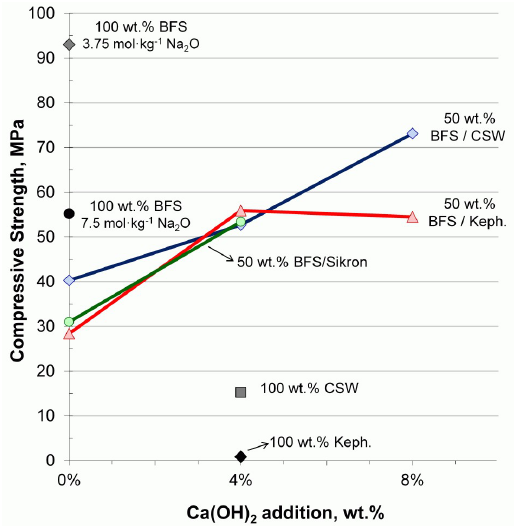
Figure 5. Compressive strength of the new mortars developed to further investigate the influence of BFS and Ca(OH) 2 on alkali-activated CSW blended systems.